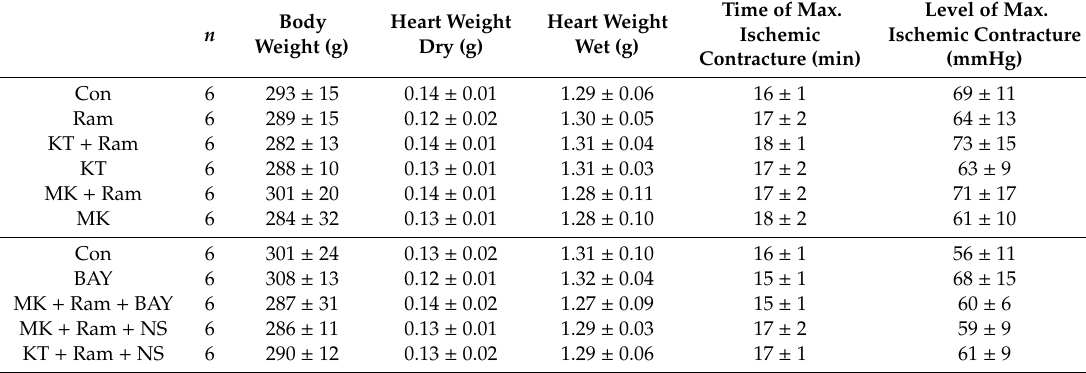
Table 1. Weights and ischemic